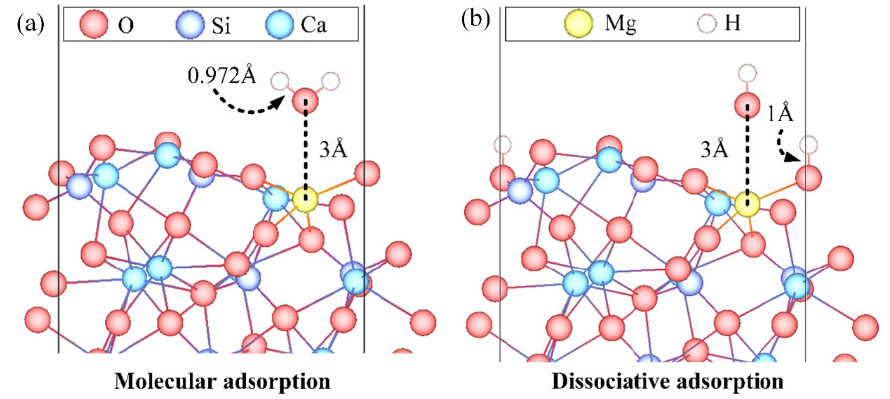
Figure 1. Initial water configuration for the ( a ) molecular and ( b ) dissociative water adsorption on the β-C 2 S (100) surface (side view).